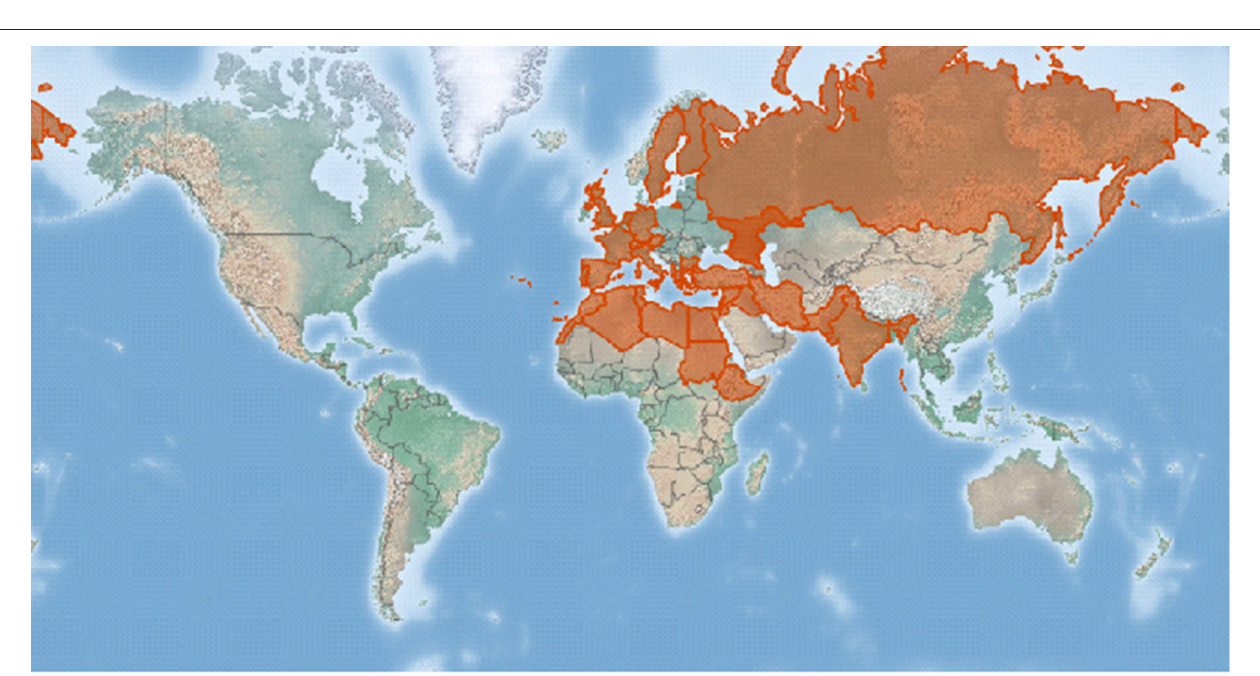
weed-free fields. Farm products, like seeds or hay, and farm tools can carry the weed seeds if contaminated in the infested